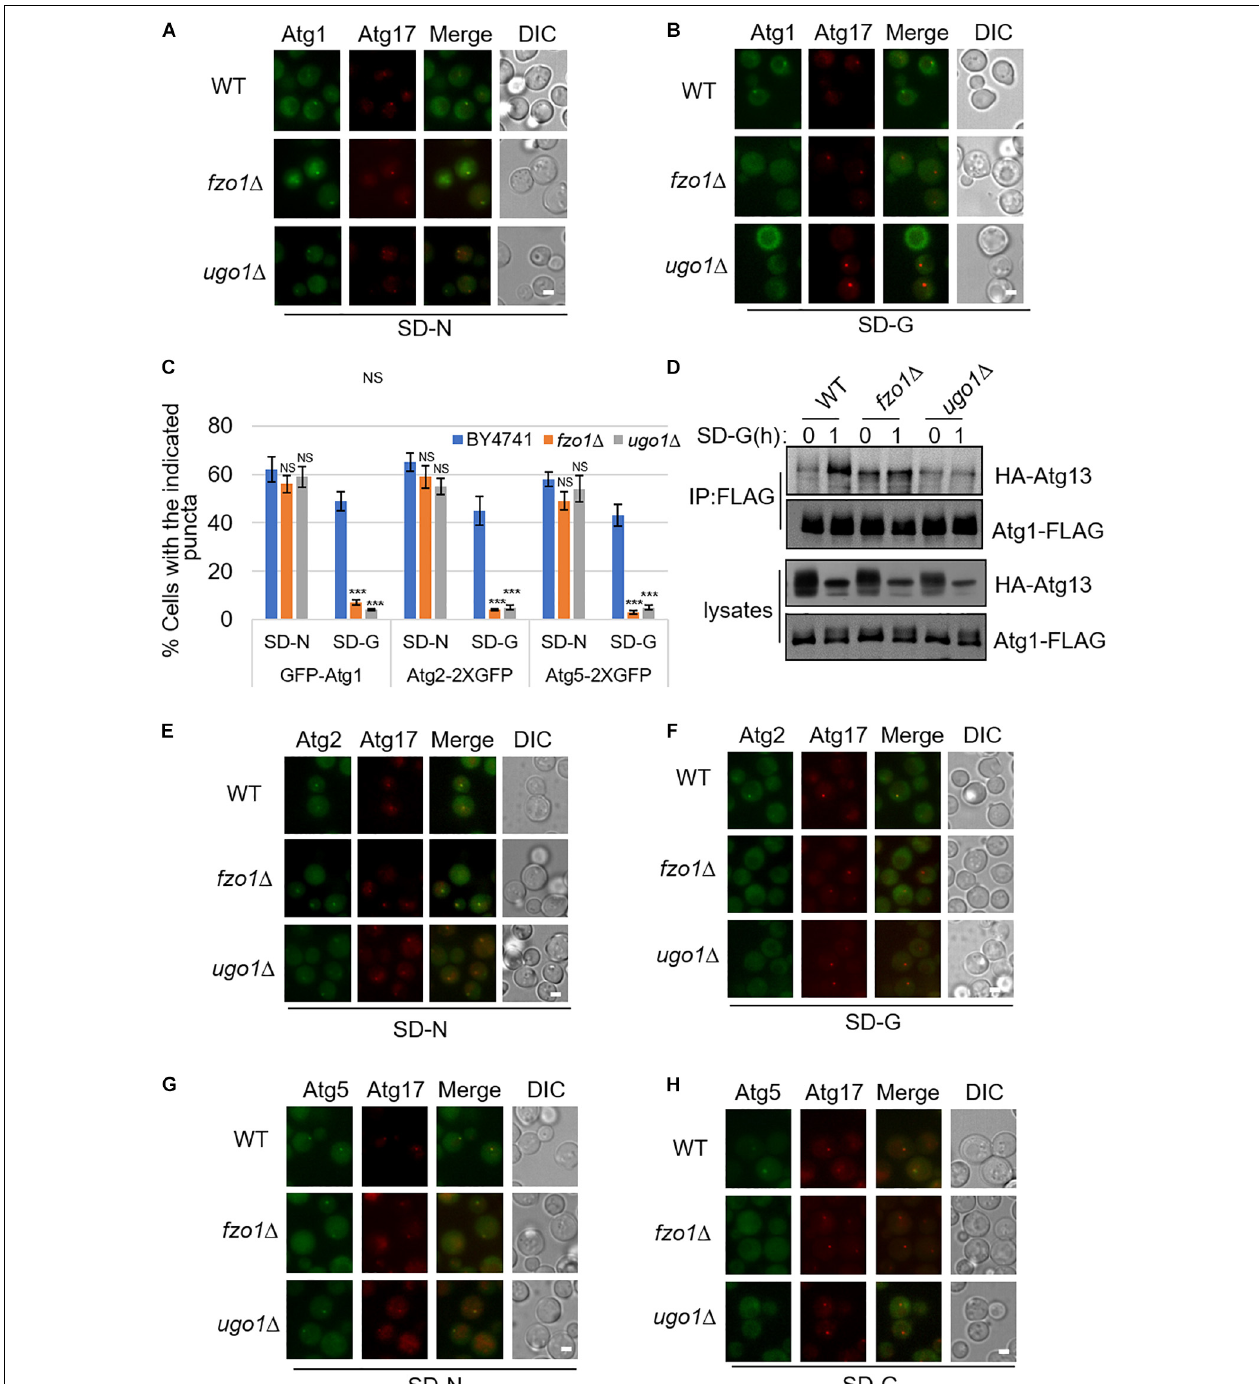
FIGURE 2 | The recruitment of Atg1, Atg2, and Atg5 to PAS is regulated by mitochondrial fusion machinery upon glucose starvation. (A,B) GFP-Atg1 and Atg17-2XCherry were co-expressed in wild type (WT), fzo1 (cid:49) , and ugo1 (cid:49) yeast strains. Yeast cells were grown to the log-growth phase, then subjected to SD-N and SD-G for 1 h. Cells were imaged by fluorescence inverted microscope. Scale bar, 2 µ m. (C) Strains from (A , B , E–H) were analyzed for the number of cells with the indicated puncta. n = 300 cells pooled from three independent experiments. Data are presented as means ± SD. *** p < 0.001; NS, not significant; two-tailed Student’s t -tests were used. (D) Wild type (WT), fzo1 (cid:49) , and ugo1 (cid:49) yeast cells co-expressing HA-Atg13 and Atg1-3XFLAG were subjected to SD-G for 0 and 1 h. Cell lysates were immunoprecipitated with anti-FLAG agarose beads and then analyzed by western blot using anti-HA antibody. (E–H) Atg2-2XGFP or Atg5-2XGFP and Atg17-2XCherry were co-expressed in the wild type (WT), fzo1 (cid:49) , and ugo1 (cid:49) yeast strains. Yeast cells were grown to the log-growth phase, then were starved in SD-N and SD-G medium for 1 h. Cells were viewed by fluorescence inverted microscope. Scale bar, 2 µ m.